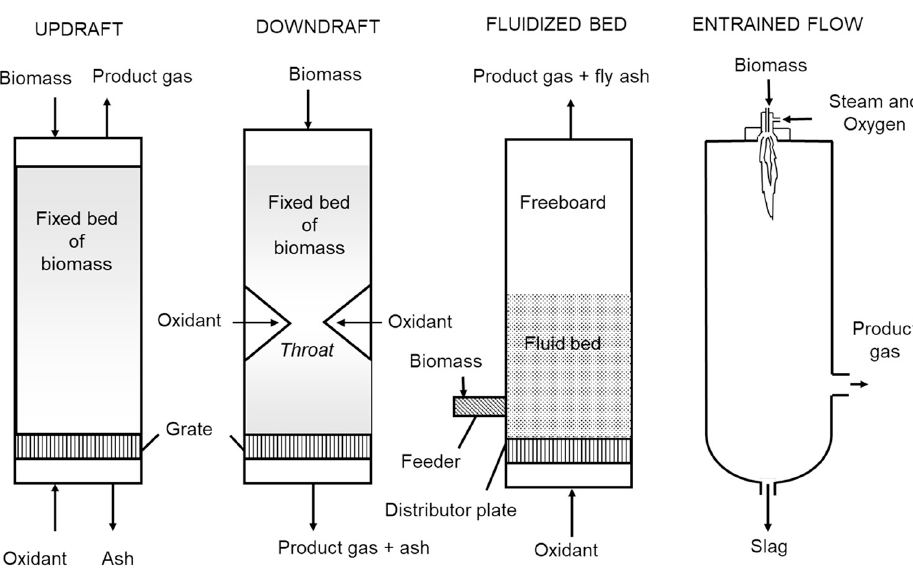
Figure 9. Classification of gasifiers according to the method of contacting solid feedstock and gasification agent (Reprinted with permission from ref. [18]. Copyright 2014 Wiley Books.)